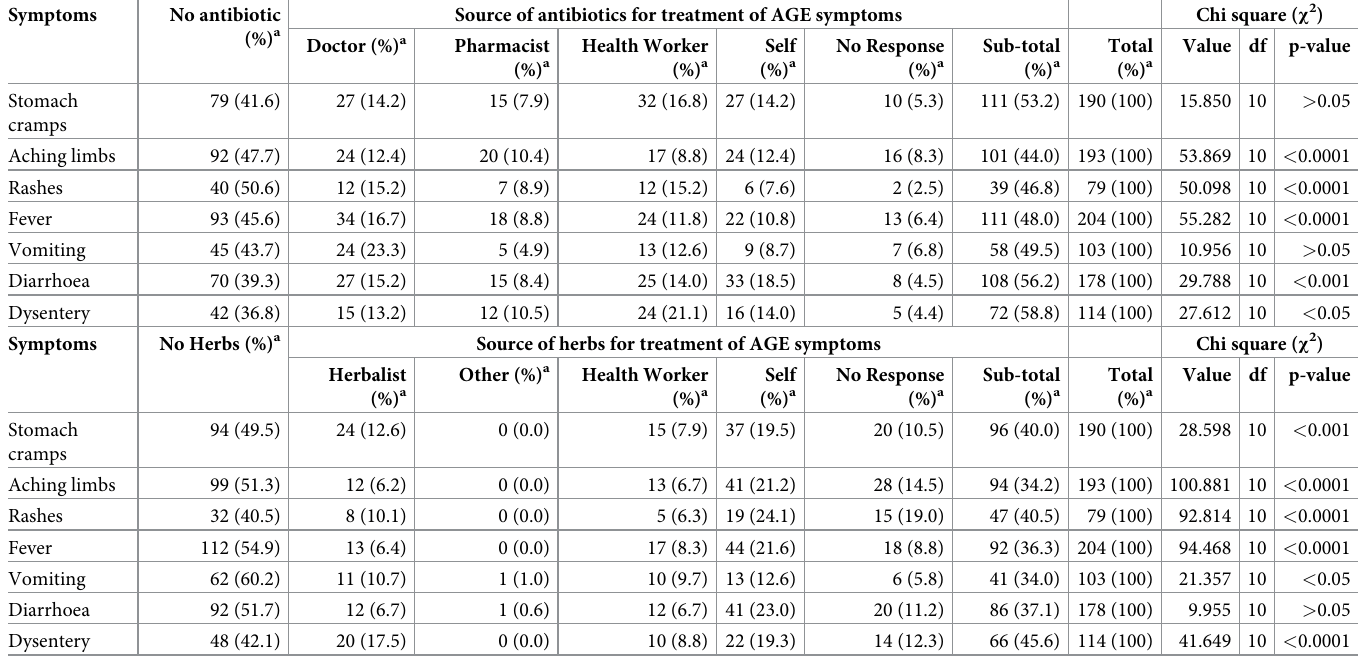
Table 1. The source of antibiotics and traditional herbal medicine reported by respondents, for the symptoms listed.